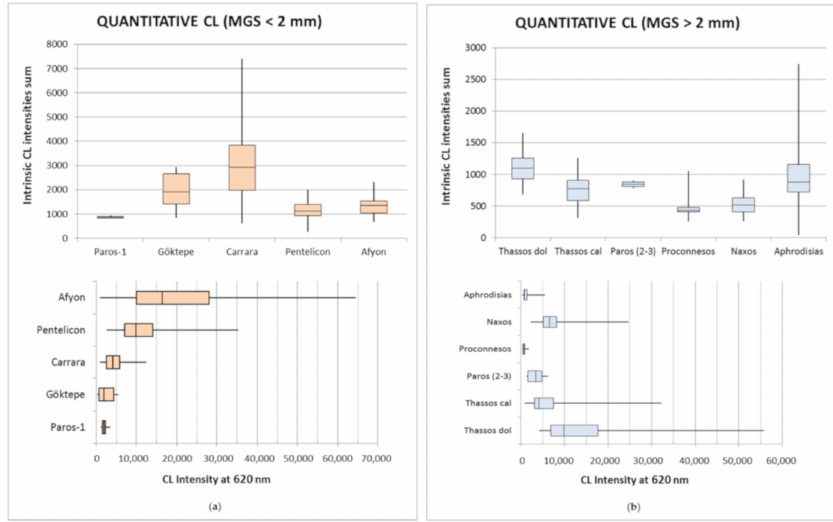
Figure 9. General quantitative CL boxplots and whiskers diagrams for the main classical marbles according to their maximum grain size. Medians, 25th and 75th percentiles, and min-max ranges are denoted by a central line, box, and whiskers, respectively. The extrinsic and the intrinsic CL are represented by the horizontal and vertical boxes, respectively. In the whiskers lines are included outliers ( a ) Diagram for fine-grained marbles (MGS < 2 mm); ( b ) diagram for medium to coarse-grained marbles (MGS > 2 mm).